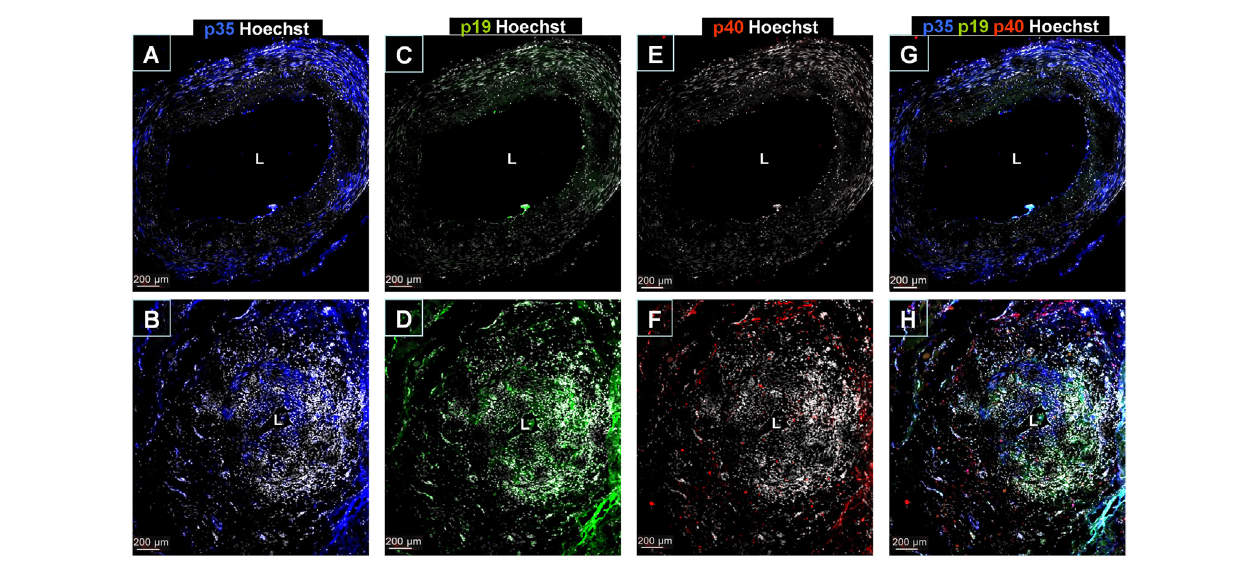
FigUre 2 | Immunofluorescence detection of IL-12/23p40, IL-12p35, and IL-23p19 subunit expression in temporal artery lesions. (a) IL-12p35 staining (blue) in a temporal artery from a control individual showing almost selective expression in the media layer. Nuclei were stained with Hoechst (white). (B) IL-12p35 expression in GCA-involved temporal artery section, predominantly in inflammatory infiltrates. (c,D) Negative IL-23p19 immunostaining (green) in sections of normal temporal arteries (c) and intense expression in GCA samples (D) where IL-23p19 expression can be observed in all arterial layers especially in the most inflamed areas. (e) Lack of IL-12/23p40 immunostaining in a temporal artery from a control. (F) Detection of IL-12/23p40 expression (red) in a GCA-involved temporal artery section predominantly in the adventitial layer. (g,h) IL-12p35 (blue), IL-23p19 (green) and IL-12/23p40 (red) staining merge in a temporal artery section from a control and from a GCA patient, respectively. Pictures are representative of four arteries from four GCA patients and two controls, and at least three sections per sample were